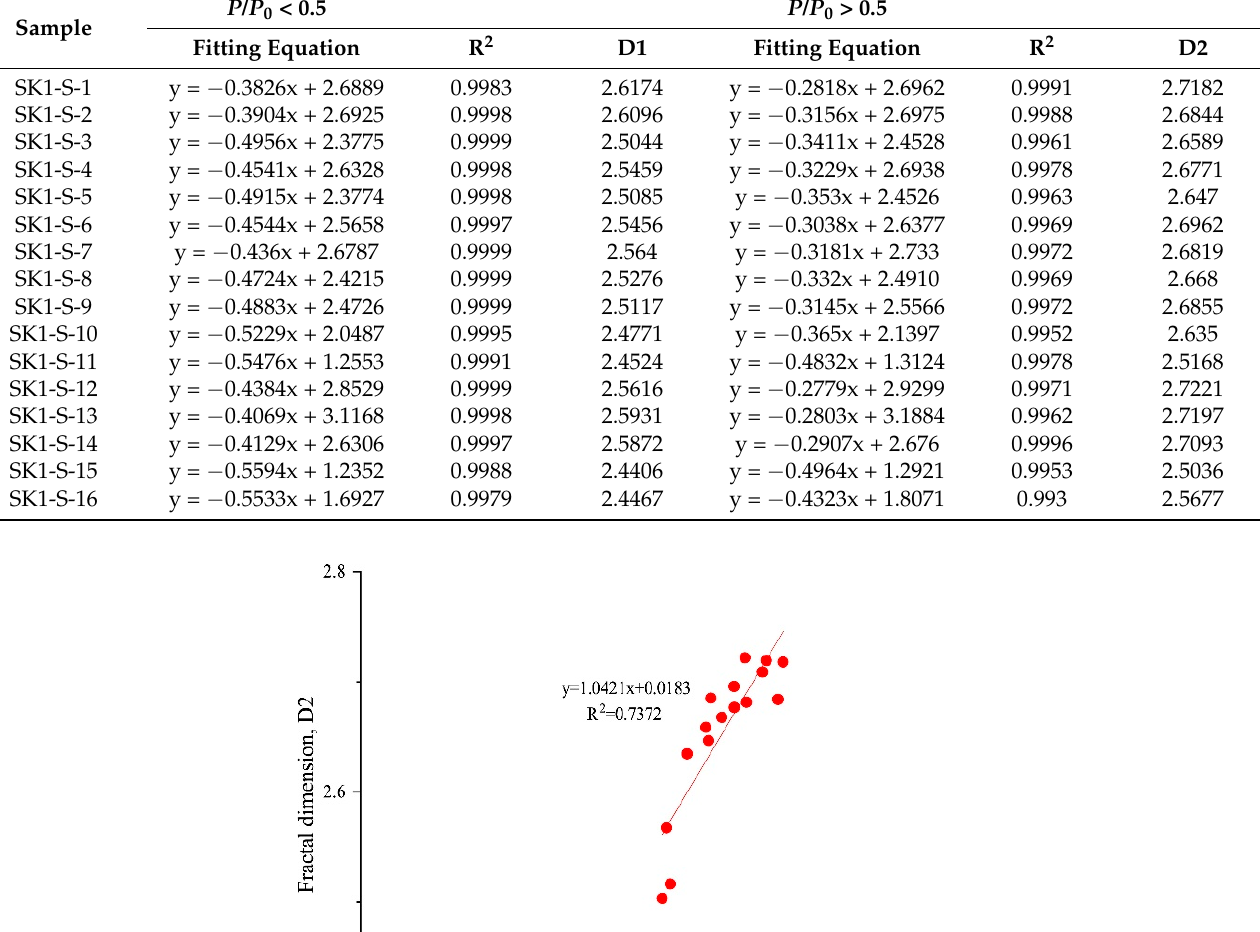
Table 4. Fractal dimensions calculated by the FHH model.